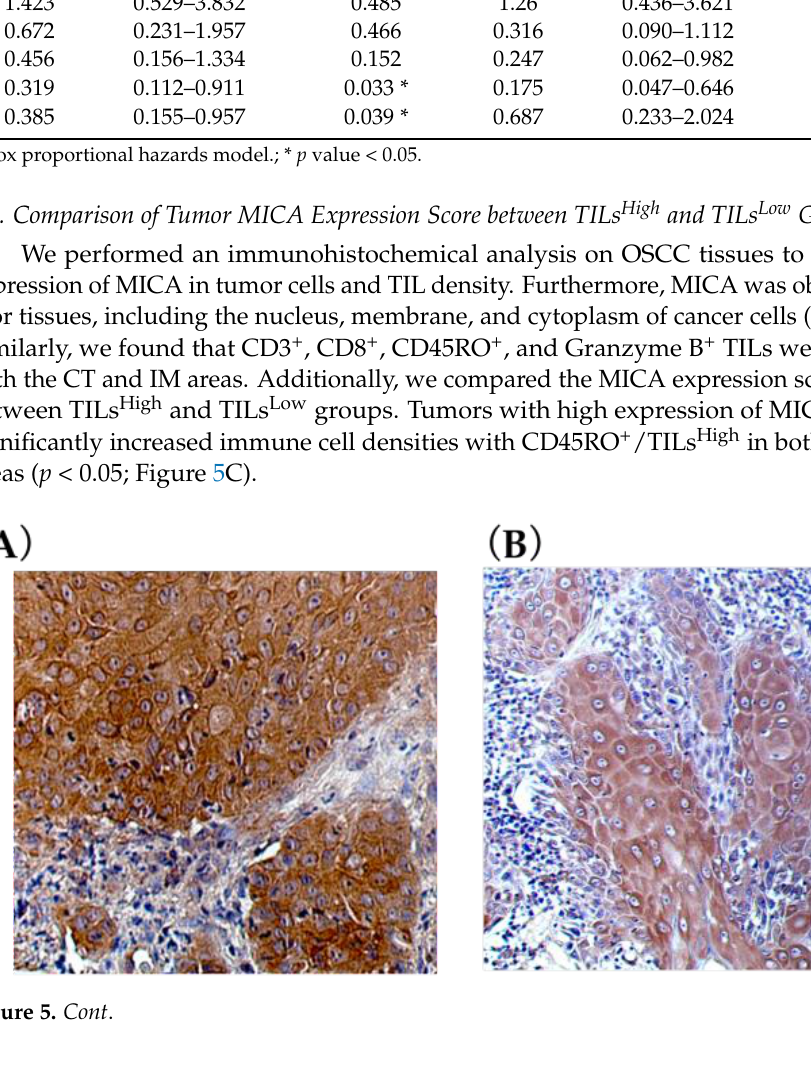
Figure 5. Comparison of the tumor MICA expression score between the TILs High and TILs Low groups. Differences in tumor MICA expression score in the TILs High and TILs Low groups were examined. Whole tumor cells were stained, showing representative examples of low ( A ) and high ( B ) expres-